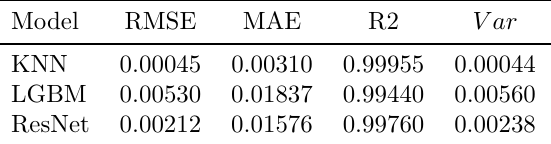
Table 6. Performance of different models on test set without reinforcement